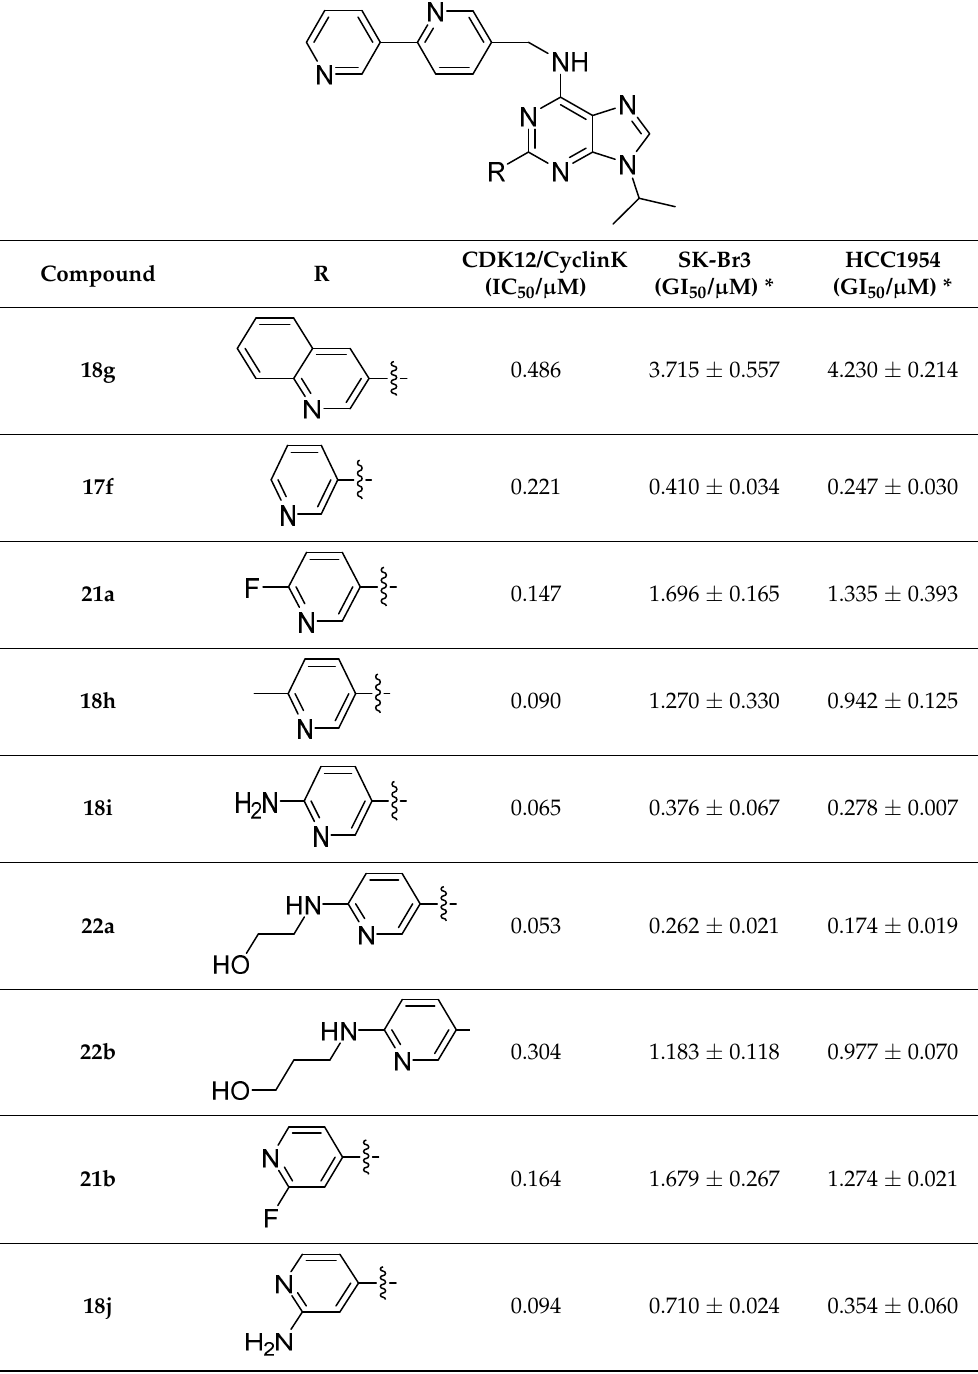
Table 3. Structure-activity relationship for heteroaryl substituents at 2 position.